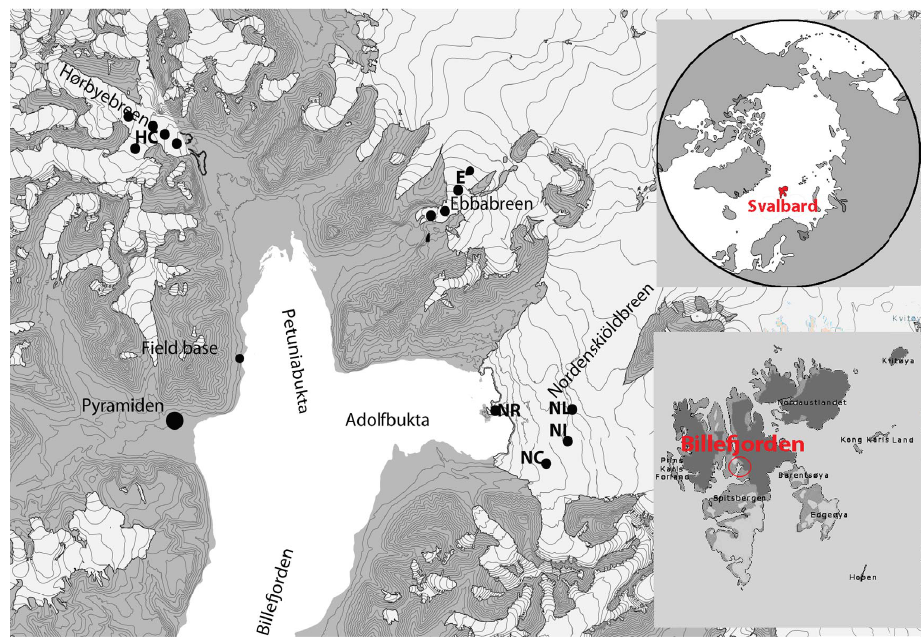
Figure 1. Sampling sites of the cryoconites. The abbreviations used are HC for Hørbyebreen, E for Ebbabreen, NC for the main site on Nordenskiöldbreen, NI for the plateau on Nordenskiöldbreen, NL for the supraglacial lake on Nordenskiöldbreen, and NR for the part of Nordenskiöldbreen next to Retrettøya. The map is modified from the geographic data of the Norwegian Polar Institute